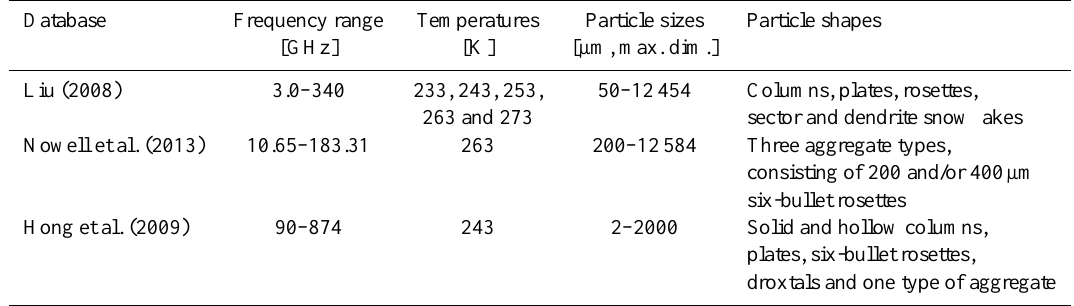
Table 1. Overview of considered DDA databases.